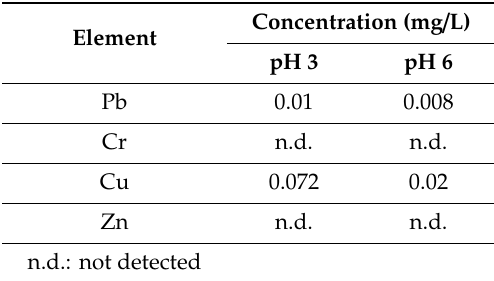
Table 1. Leachate from iron slag using deionized